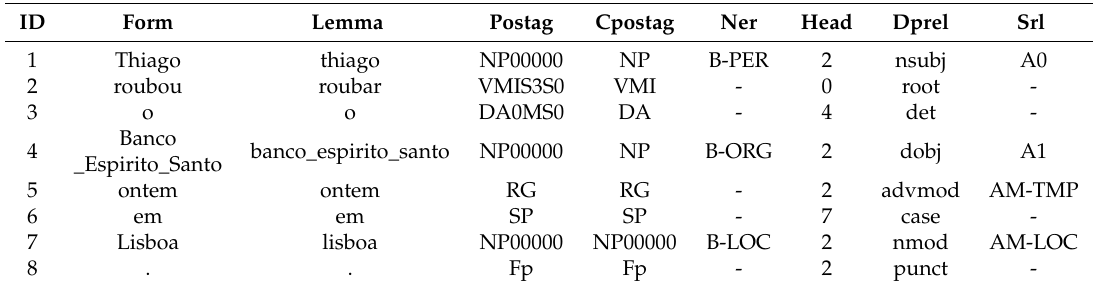
Table 1. Sample output for the different